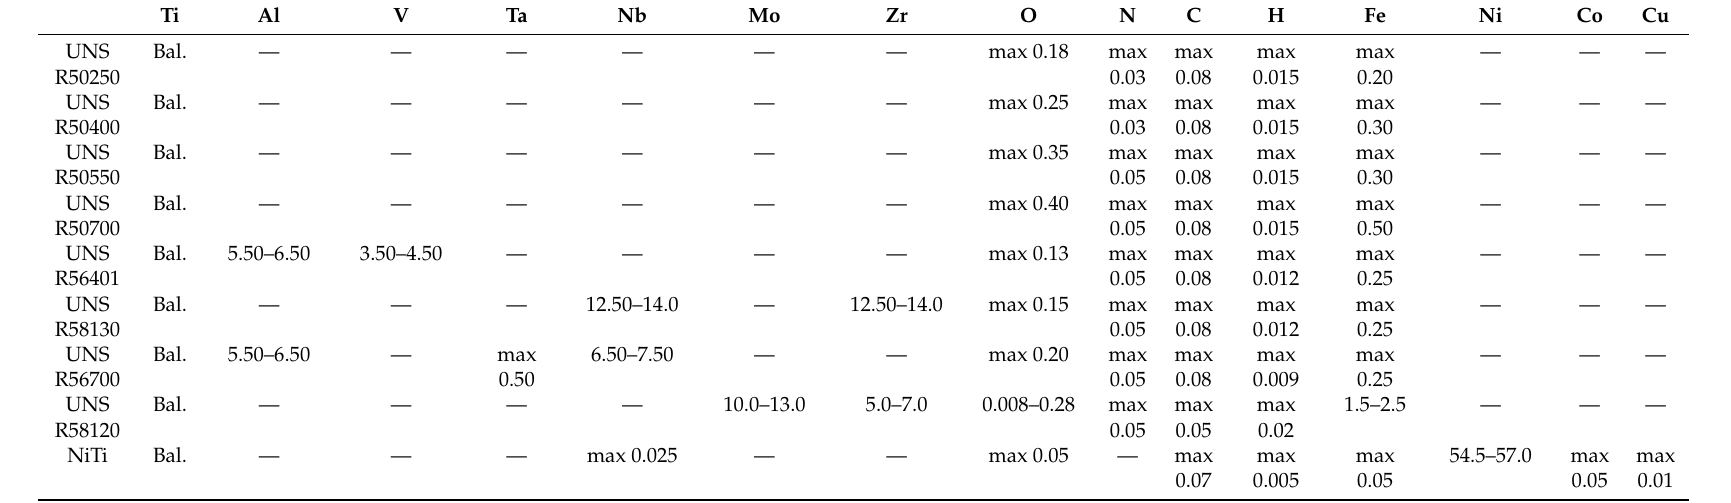
Table 6. Chemical compositions of titanium and its alloys currently in use as